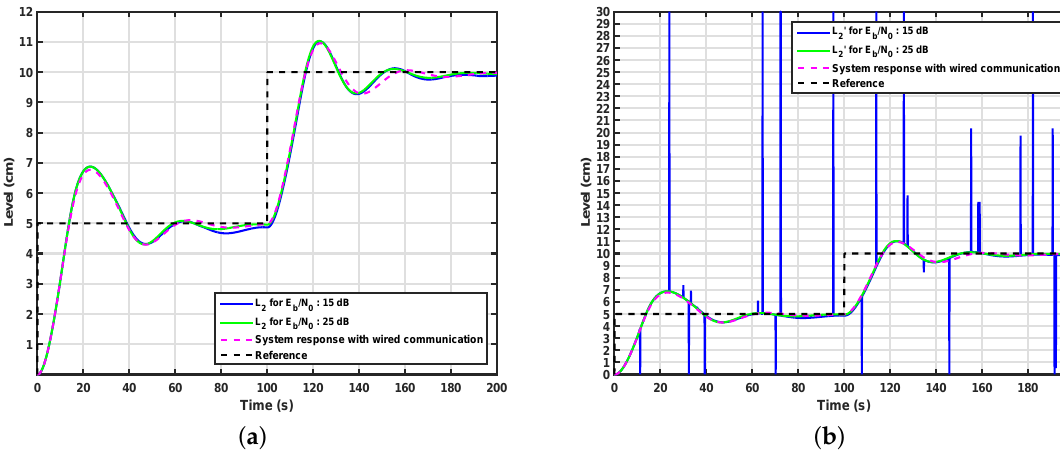
Figure 10. ( a ) System response with based wavelet coding based on 2 × 32 WCM for k = 1; ( b ) signal received by the controller in a system with wavelet coding based on 2 × 32 WCM for k = 1.